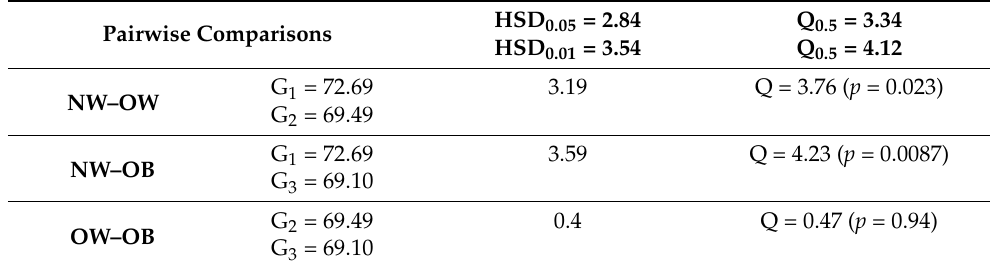
Table 2. Tukey HSD test